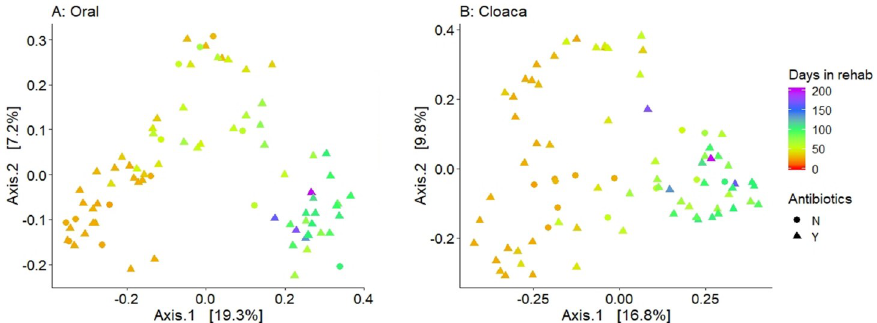
Fig 6. Microbial communities during rehabilitation to convalescence. Principal coordinate analysis (PCoA) plots of oral samples (A) and cloacal samples (B) based on Bray-Curtis distance. Color indicates number of days in rehabilitation. Shape indicates whether a turtle was not on antibiotics (circle, N) or on antibiotics (triangle, Y) during rehabilitation.